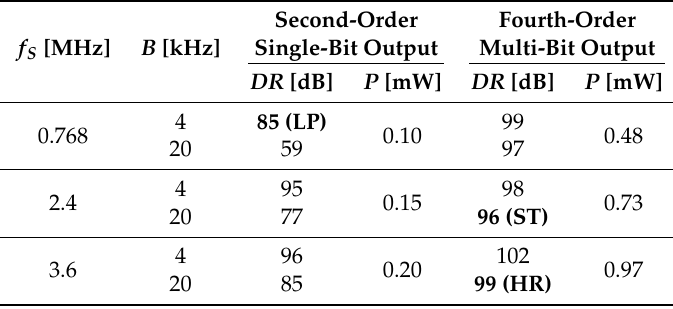
Table 3. DR and power consumption in the different operating modes (example